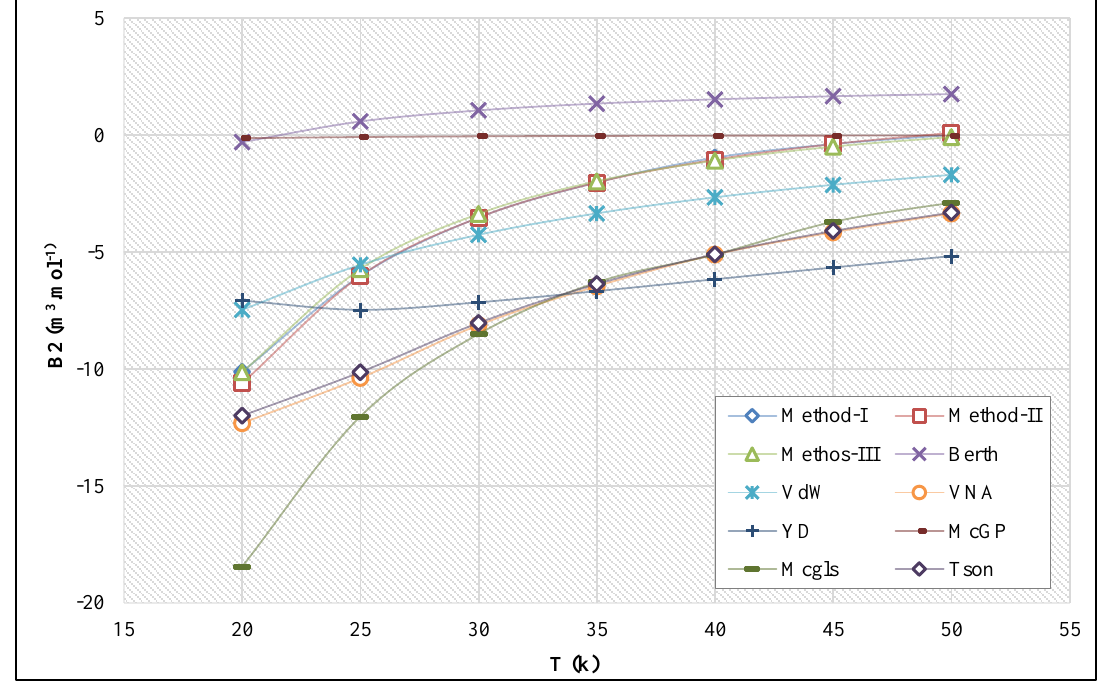
Figure 4. Second Virial Coefficient of